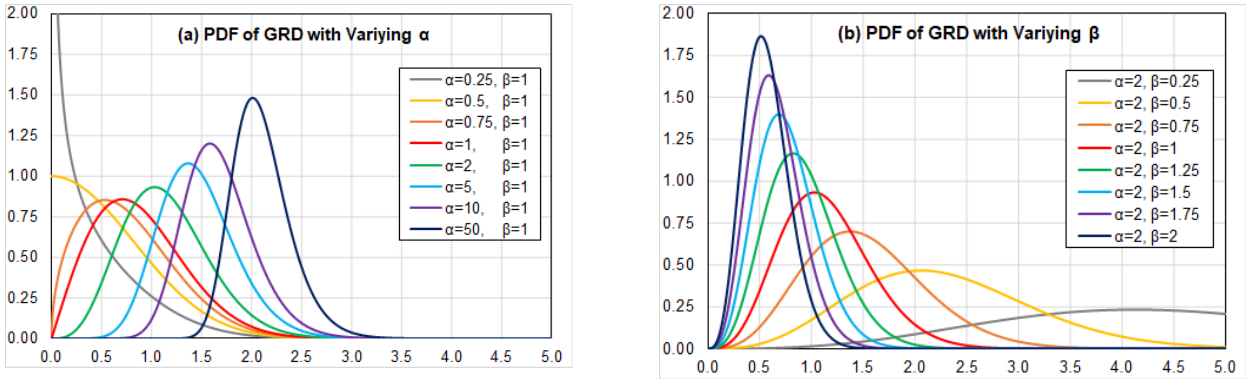
Figure 3. PDF of Generalized Rayleigh Distribution for Varying Parameters α ( a ) and β ( b ).